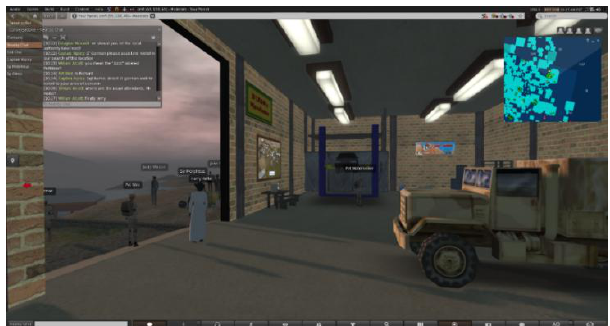
Figure 1: MOSES Virtual